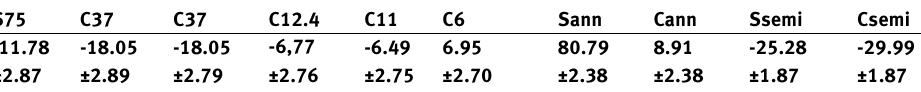
Table 3. Statistically significant estimated components of periodicities and their SEs. C is for cosine, S is for the sine component of a peri- odicity. The concatenated numbers to C and S are the rounded periods in years given in Table 1. Units are in mm. S75